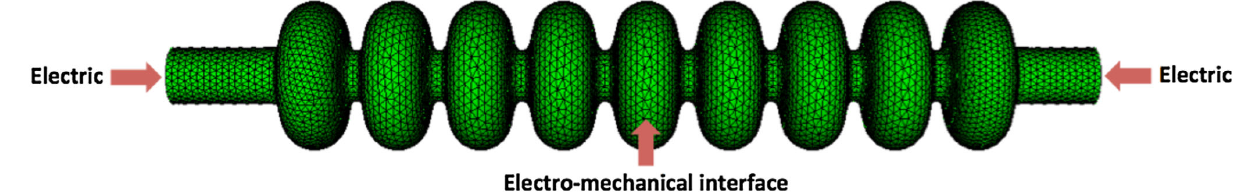
FIG. 4. Vacuum model of the TESLA cavity meshed with curved tetrahedral elements. Also shown are the boundary conditions and the electromechanical interface.